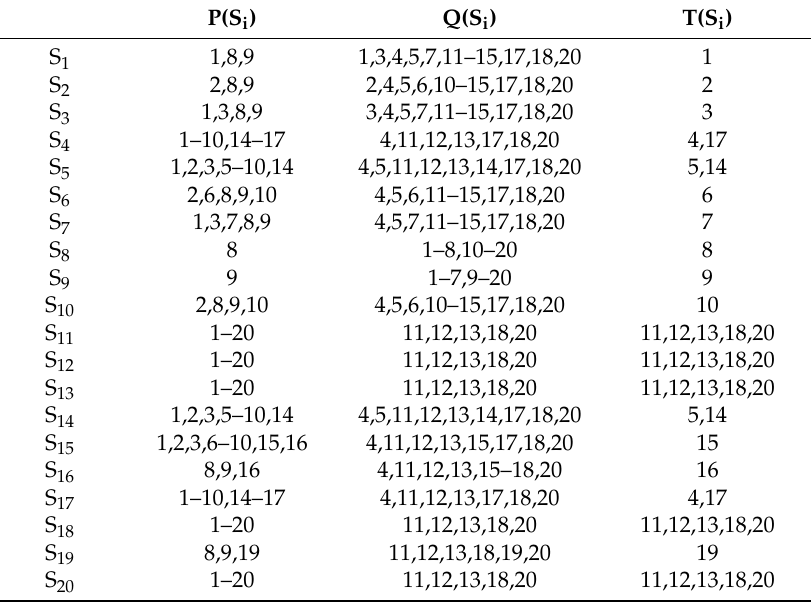
Table 6. First level of reachability set, leading set, and their